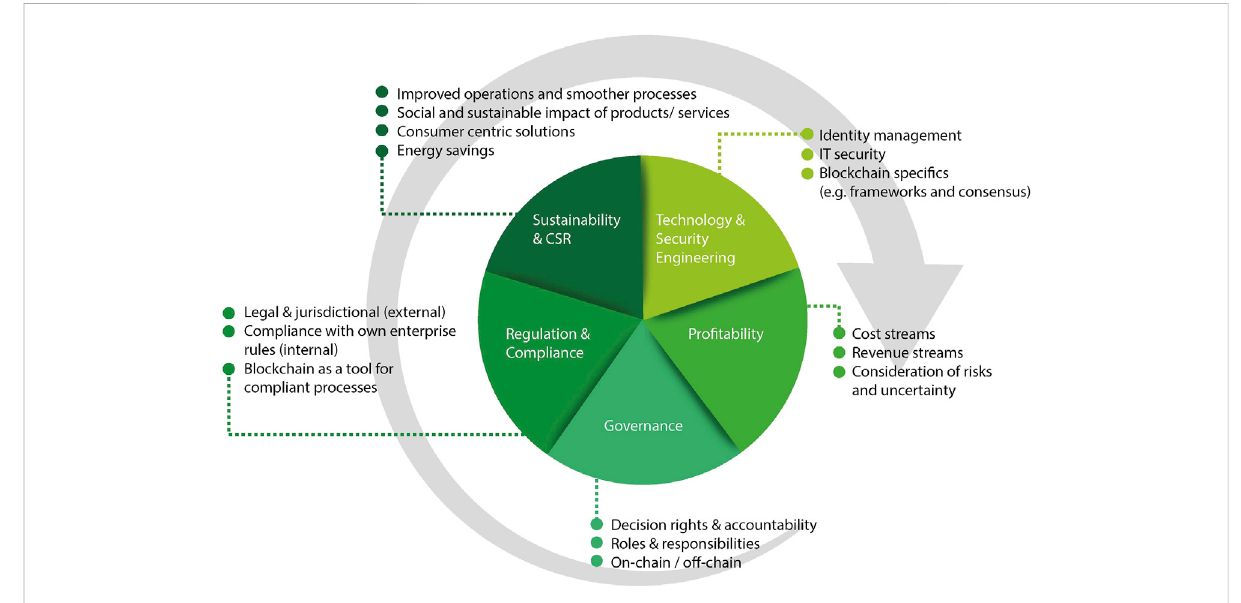
FIGURE 1 Framework for enterprise blockchain consortium